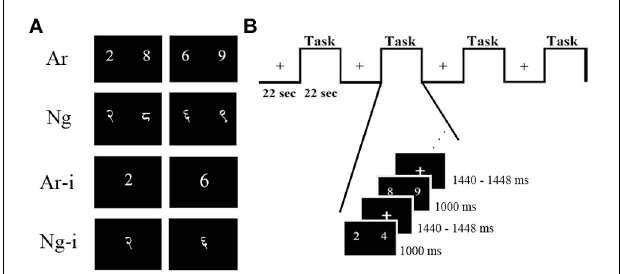
FIGURE 1 | Examples of stimuli and task design. (A) Two symbolic notations were used as stimuli for number comparison (Ar, Ng) and number identification (Ar-i, Ng-i) tasks. Participants chose which of the two numbers was greater in magnitude in number comparison task and named the presented number in number identification task, (B) details of experimental design and timing for one comparison run. Each run had four task blocks alternating with four rest